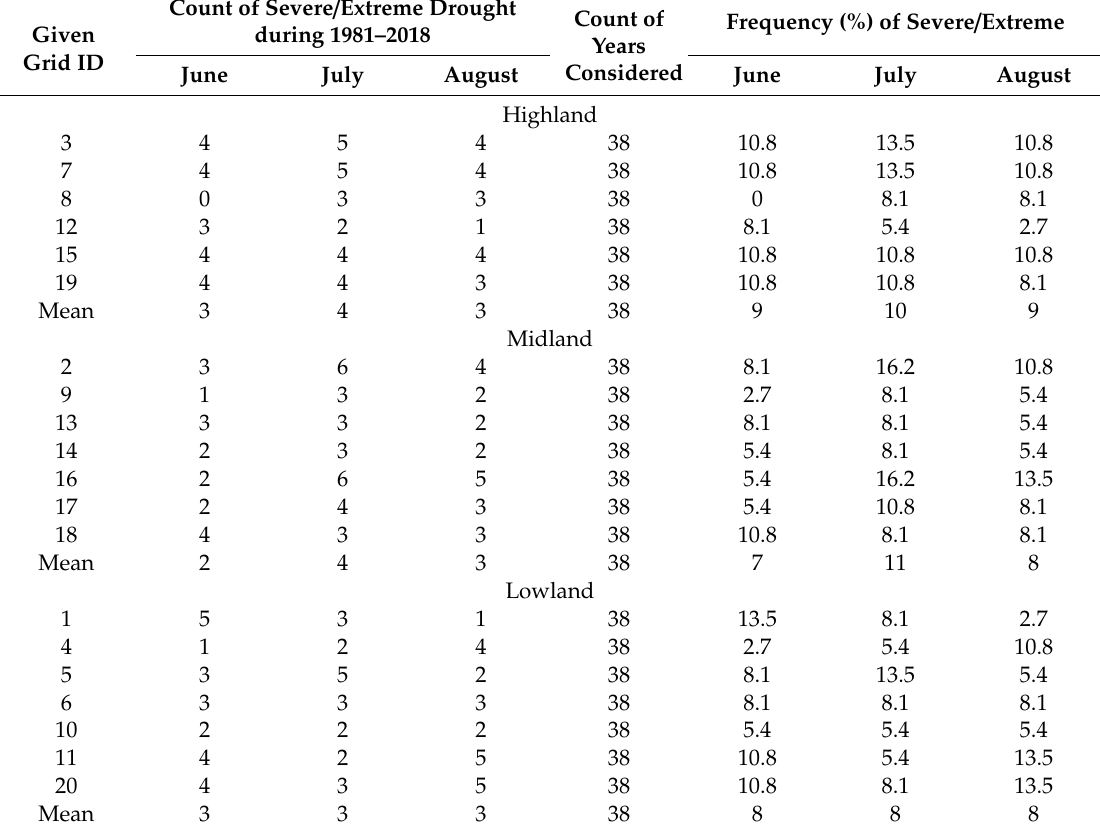
Table 6. The frequency (%) of severe / extreme meteorological drought months * during 1981–2018 for the elevation zones of Upper Blue